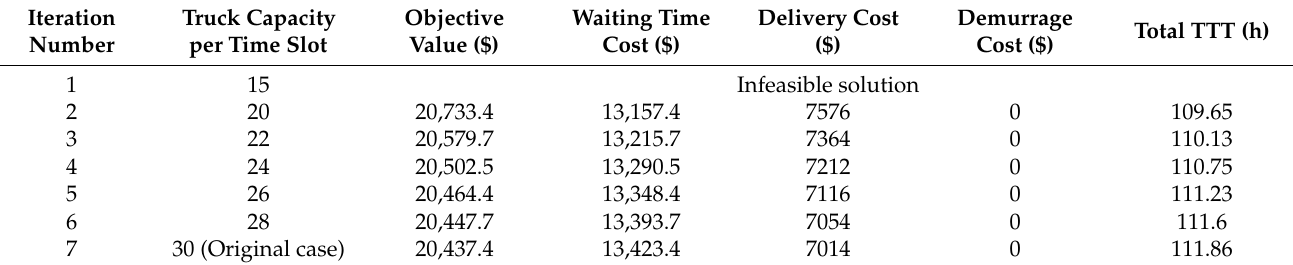
Table 11. The sensitivity analysis results of instance 8.